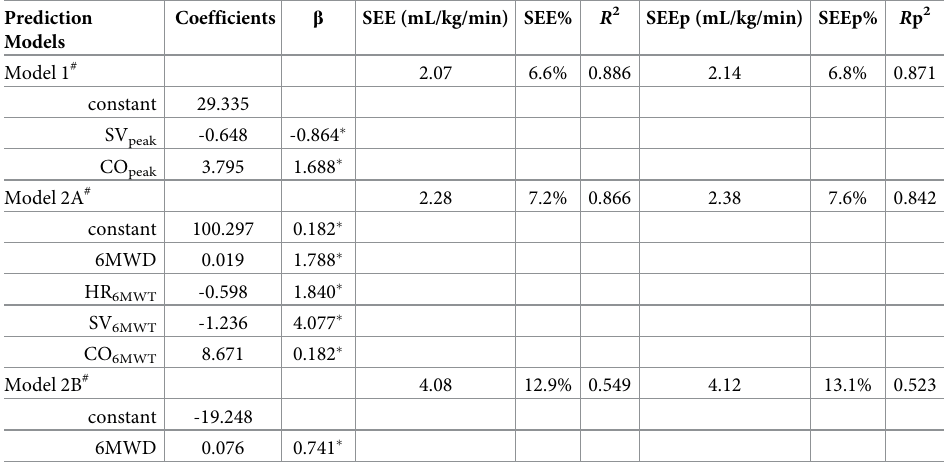
Table 5. Multiple regression analyses for prediction of VO 2peak